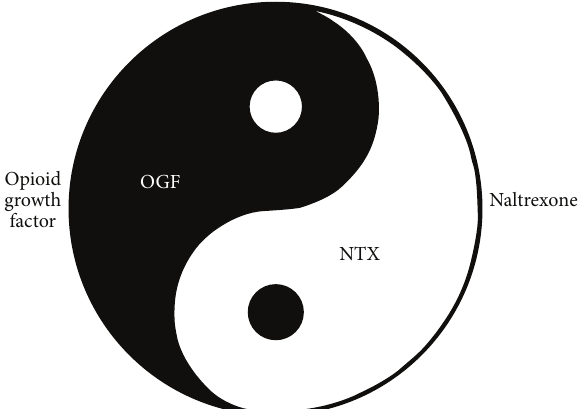
Figure 1: The figure illustrates the two opposing “Yin and Yang” entities: opioid growth factor (OGF), [ Met 5 ] -enkephalin, which initiates downregulation of cell division, and naltrexone (NTX), which blocks the receptor (OGFr) for OGF resulting in upregulation of cell division and facilitation of epithelial wound healing.